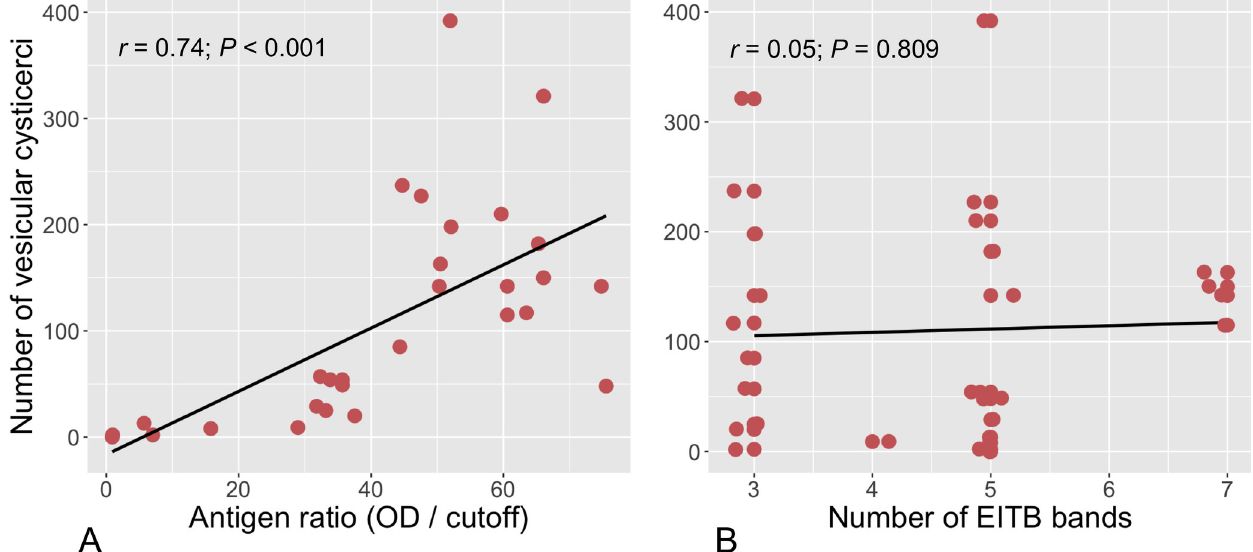
Fig 5. Spearman’s rank correlations coefficients between the number of vesicular cysticerci found in pigs at the time of necropsy with antigen levels on Ag-ELISA (A) and antibody bands on EITB (B).